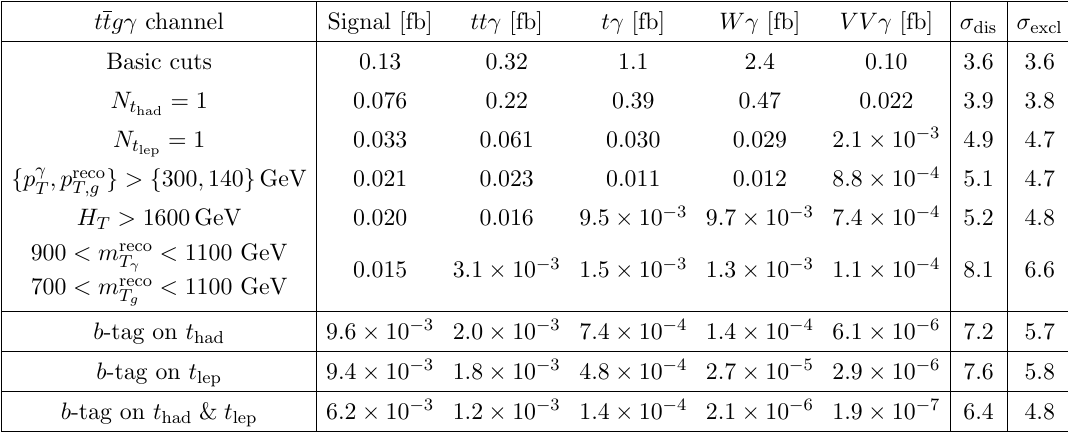
Table 4 . A cumulative cut-(cid:13)ow table showing the SM backgrounds and signal cross sections in the ttg(cid:13) channel for m T = 1 : 0 TeV. The signi(cid:12)cances (cid:27) dis and (cid:27) excl are calculated based on the likelihood-ratio methods de(cid:12)ned in eq. (4.22) and eq. (4.24) respectively for a given luminosity of 3 ab (cid:0) 1 . The summary of the background simulations can be found in table 3.